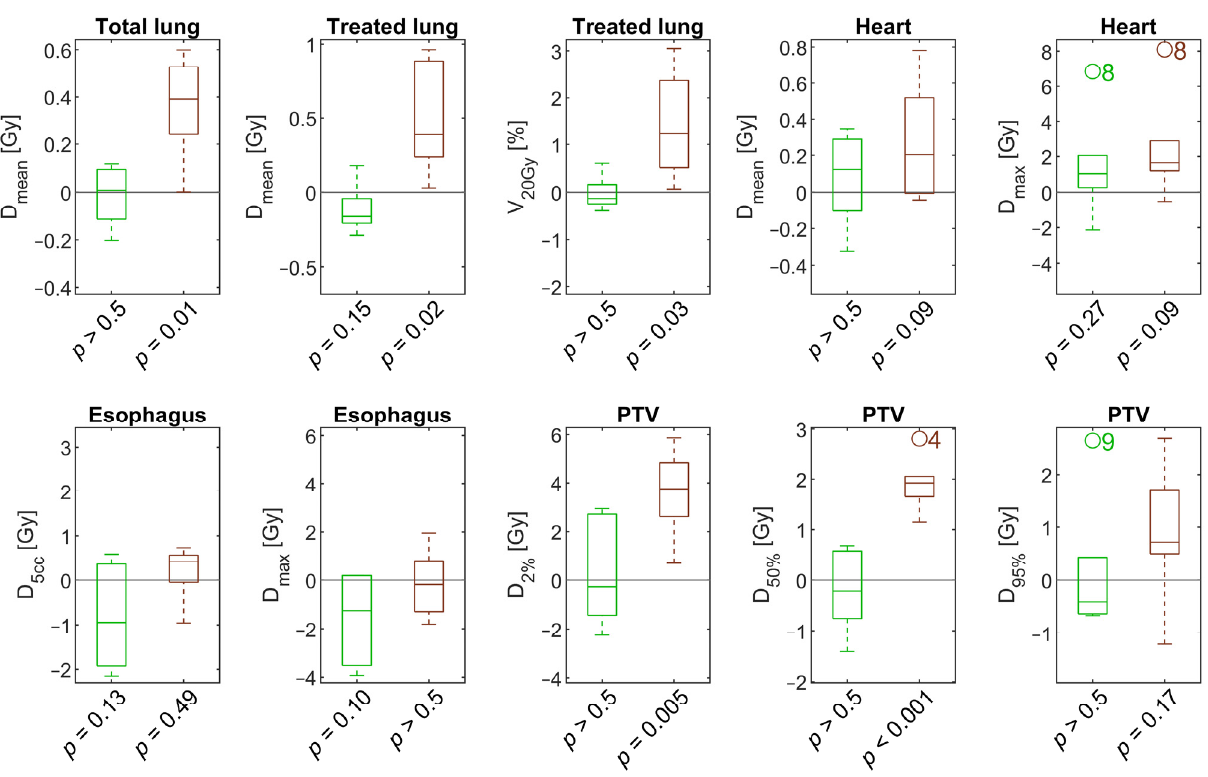
Figure 2. Boxplots showing the distribution of individual differences among the application of different gating windows. In each panel, the left part depicted in green represents the difference between plans with a gating window of 20–40 compared to 40–60. The right, brown part corresponds to the difference between a gating window of 20–70 and 40–60. Boxes show interquartile ranges with the median denoted by a separating line. Outliers are marked by circles and patient case numbers.